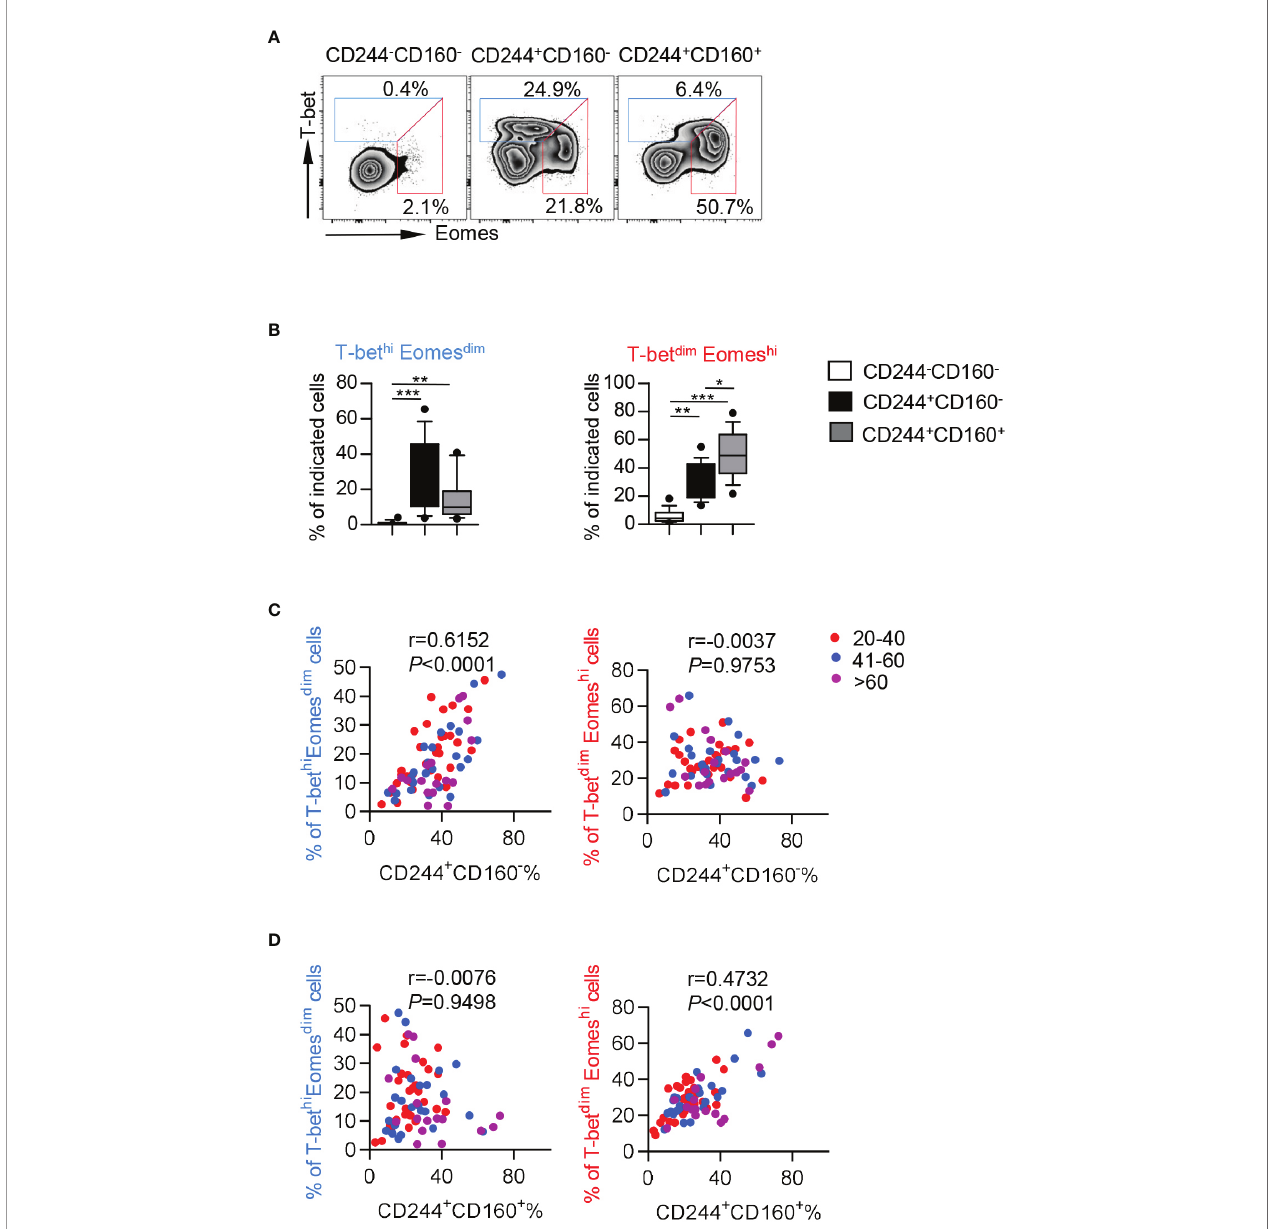
FIGURE 6 | CD244 + CD160 - CD8 + T cells from the elderly exhibited elevated T-bet hi Eomes dim cells while CD244 + CD160 + CD8 + T cells comprised a high number of T-bet dim Eomes hi cells. (A, B) Representative fl ow data (A) and box plots (B) of the percentage of T-bet dim Eomes hi and T-bet hi Eomes dim cells on CD244 - CD160 - , CD244 + CD160 - and CD244 + CD160 + CD8 + T cells in the elderly (61-90 years old, n = 17). P values were obtained by Friedman ’ s test followed by Dunn ’ s multiple comparisons test. (C, D) Correlation analysis of the percentage of CD244 + CD160 - and CD244 + CD160 + cells and the frequencies of T-bet hi Eomes dim and T-bet dim Eomes hi cells on CD8 + T cells of all ages. Spearman ’ s non-parametric test was used to test for correlations. * P < 0.05, ** P < 0.01, *** P <